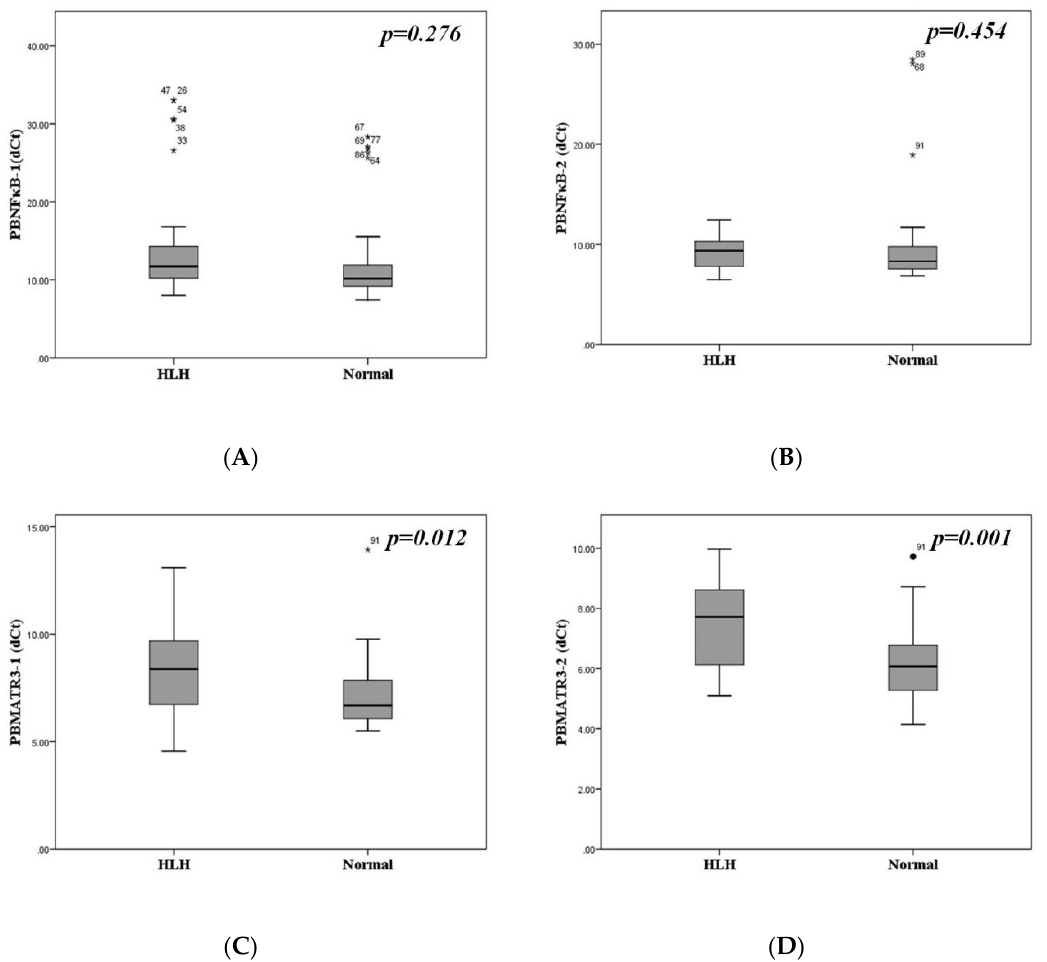
Figure 2. NFκB and MATR3 mRNA expressions, using two different pairs of primers, in the peripheral blood mononuclear cells of patients with hemophagocytosis (HLH) and healthy volunteers. ( A ) NFκB-1 mRNA expression (dCt), ( B ) NFκB-2 mRNA expression (dCt), ( C ) MATR3-1 mRNA expression (dCt), and ( D ) MATR3-2 mRNA expression (dCt). MATR3 -mRNA expressions showed significant difference between HLH patients and normal volunteers.